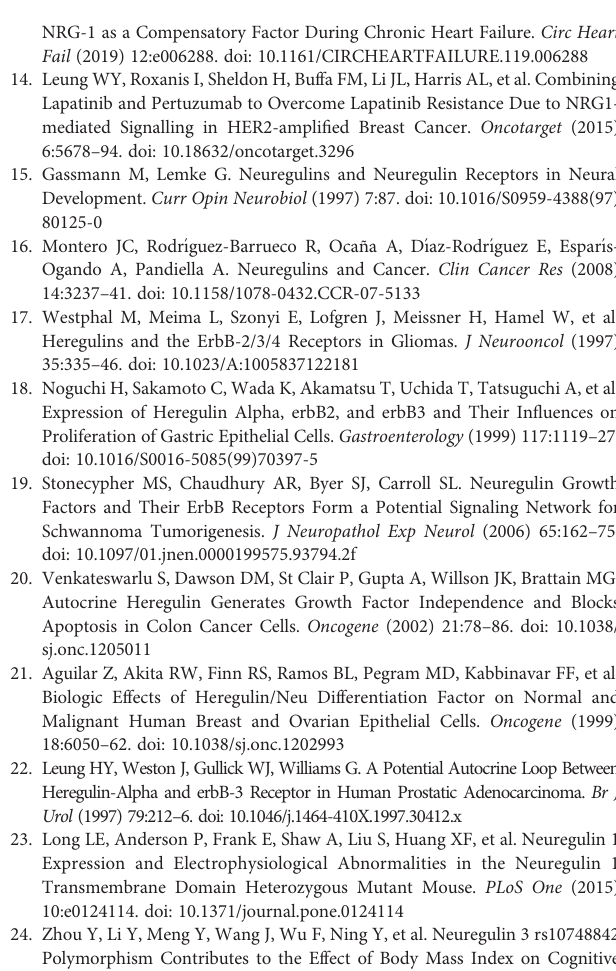
Supplementary Figure 1 | The prognostic value of NRG1 in primary and recurrent gliomas in different WHO grades. Supplementary Figure 2 | The prognostic value of NRG2 in primary and recurrent gliomas in different WHO grades. Supplementary Figure 3 | The prognostic value of NRG3 in primary and recurrent gliomas in different WHO grades. Supplementary Figure 4 | The prognostic value of NRG4 in primary and recurrent gliomas in different WHO